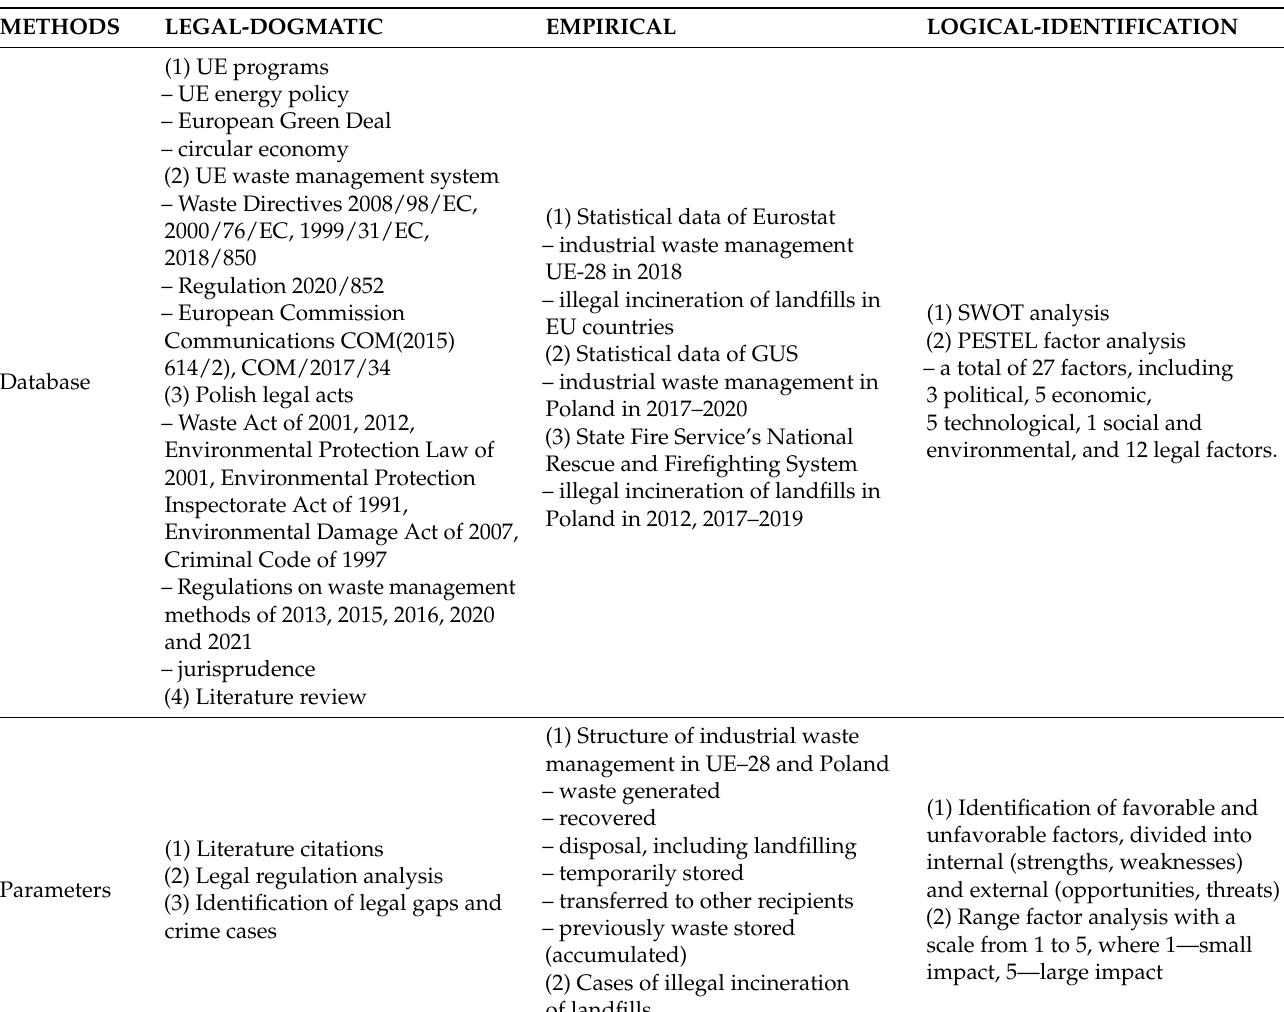
Table 1. Details of the research methods used to analysis of the industrial waste